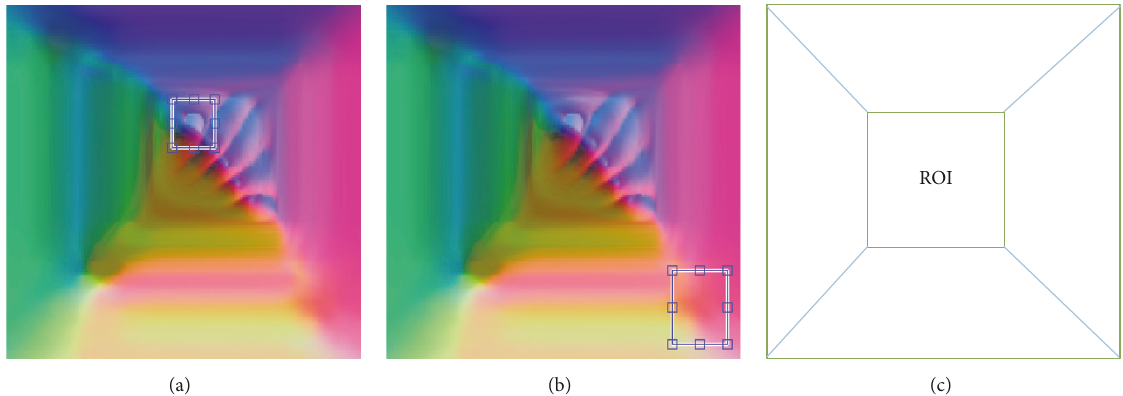
Figure 6: ROI selection for foot. From (a) to (c): ROI selection with more details, ROI selection with less details, and the ROI/non-ROI selection